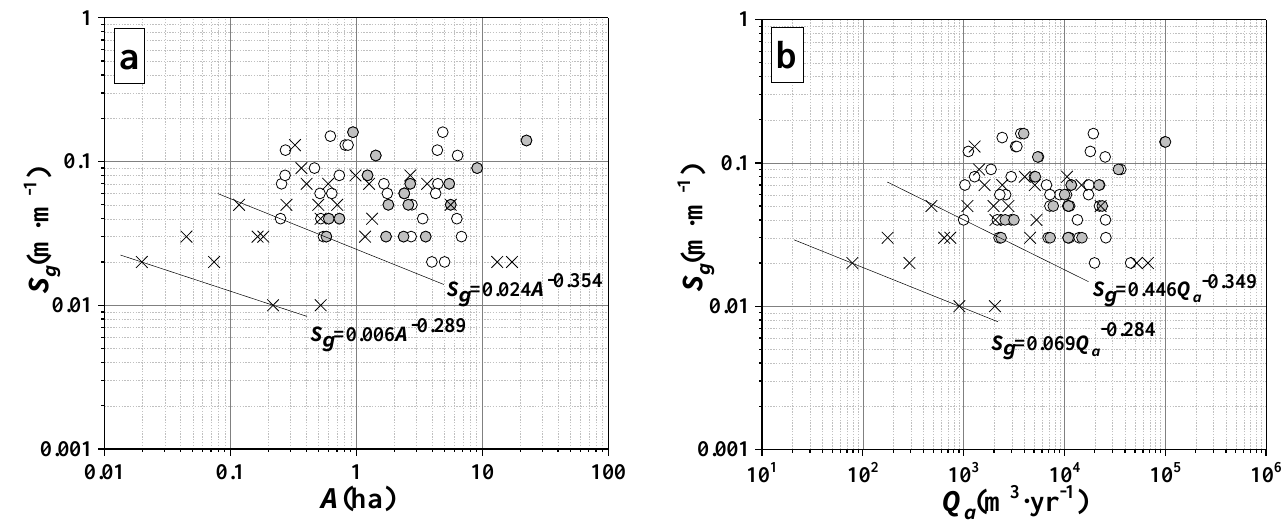
Figure 7. ( a ) S g - A topographic threshold in the study area. A -present drainage area; S g -slope gradient of the soil surface near the gully head. ( b ) S g - Q a threshold in the study area. Q a -average annual runoff to the gully head.